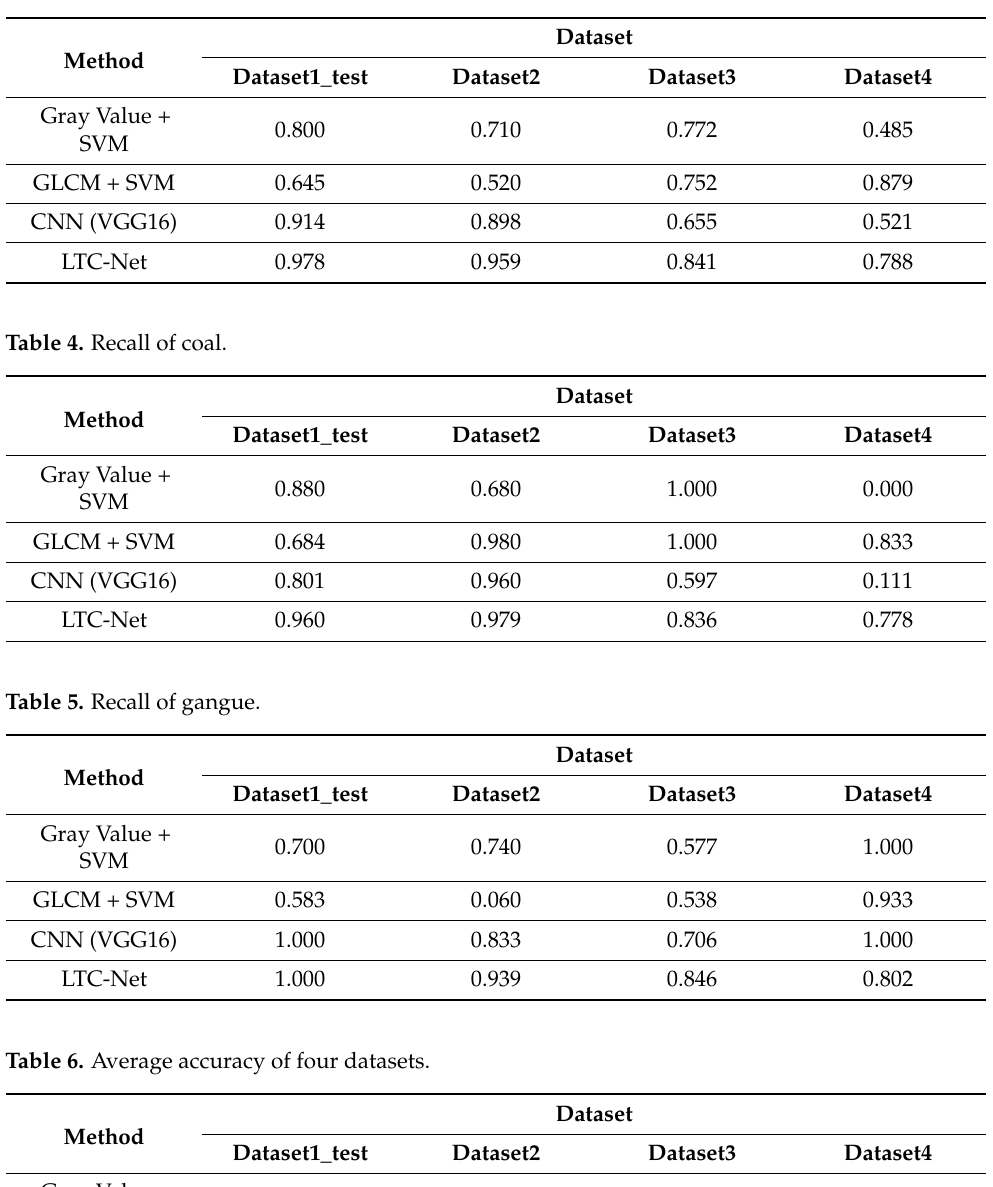
Table 3. Accuracy.